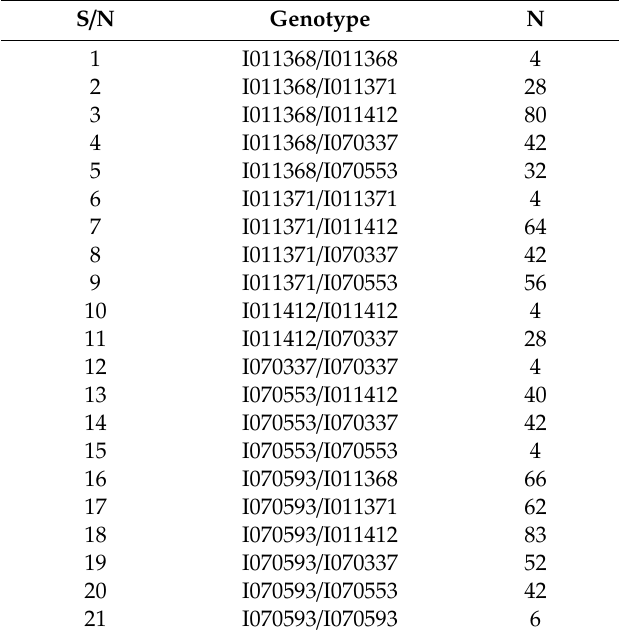
Table 2. Frequency table of the size of each